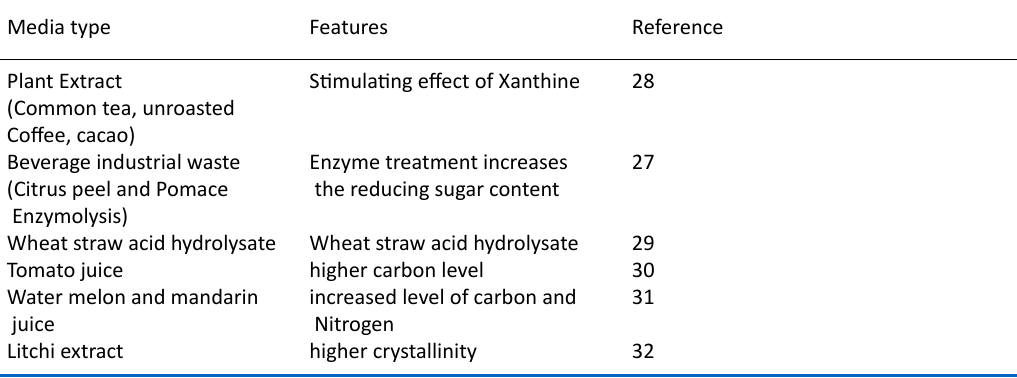
Table 2. Alternate medium used for the enumeration of Acetobacter sp Media